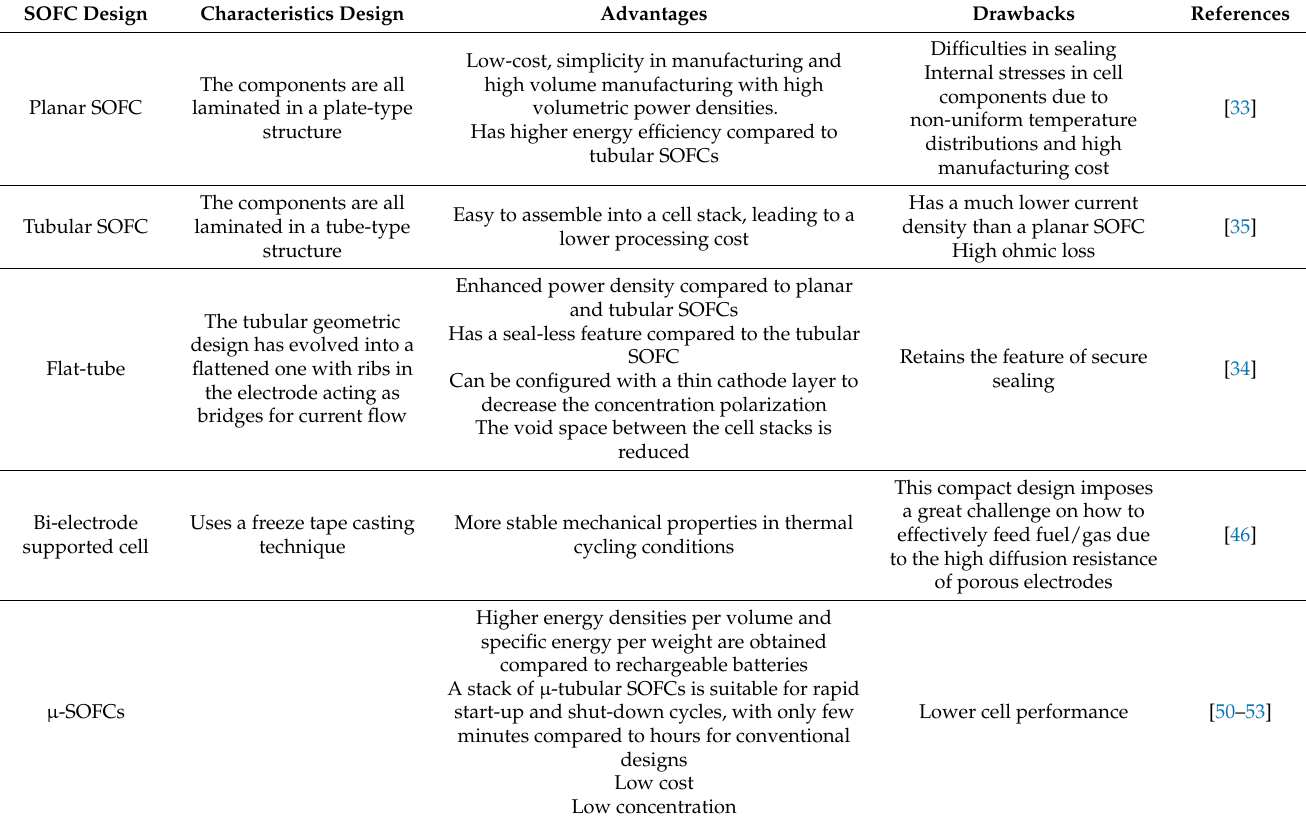
Table 2. Summary of different SOFC design